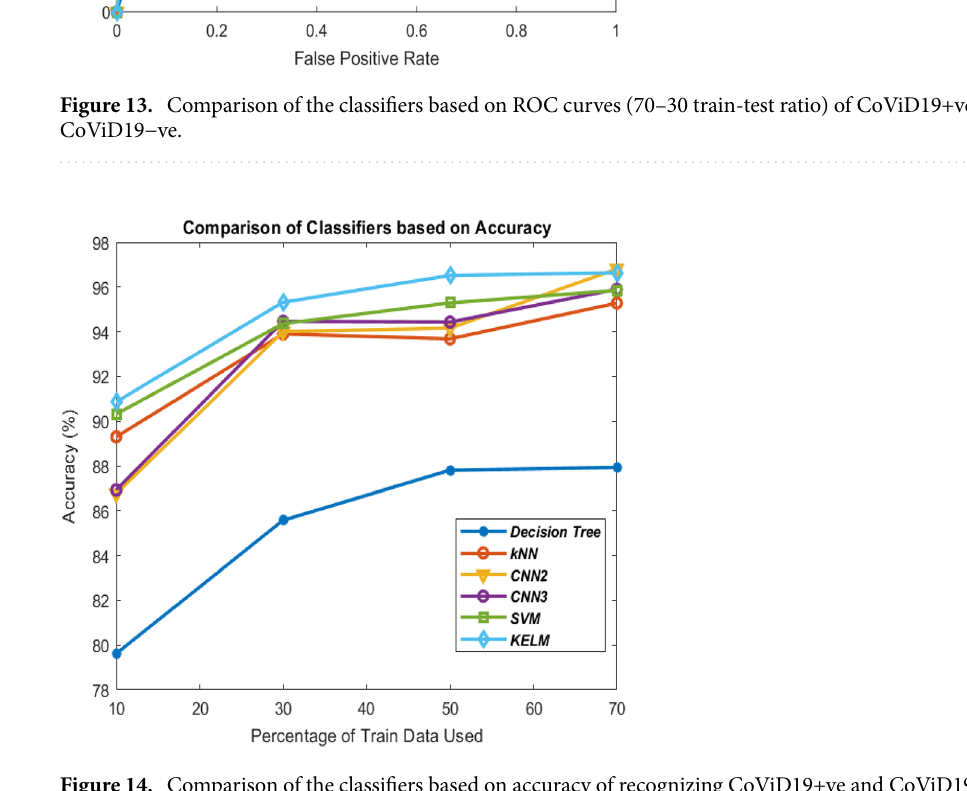
Figure 14. Comparison of the classifiers based on accuracy of recognizing CoViD19+ve and